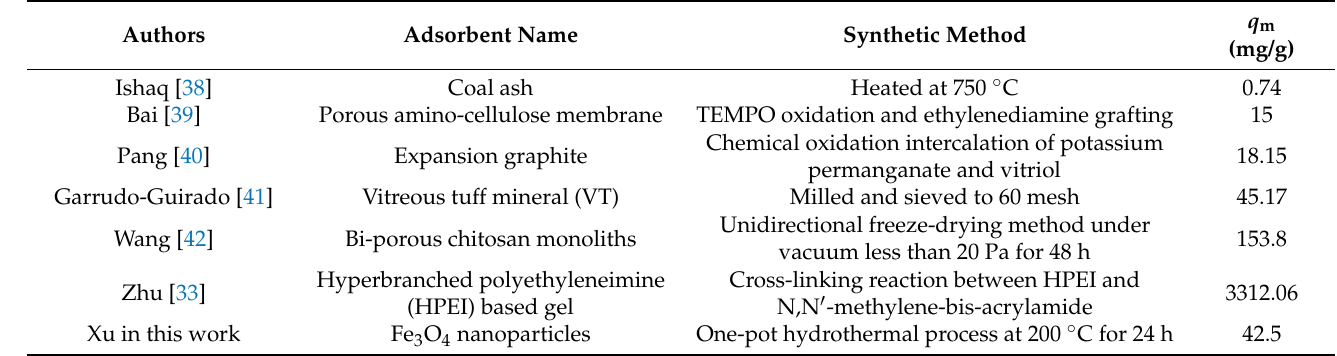
Table 3. Recent literature on adsorbent development for the removal of XO